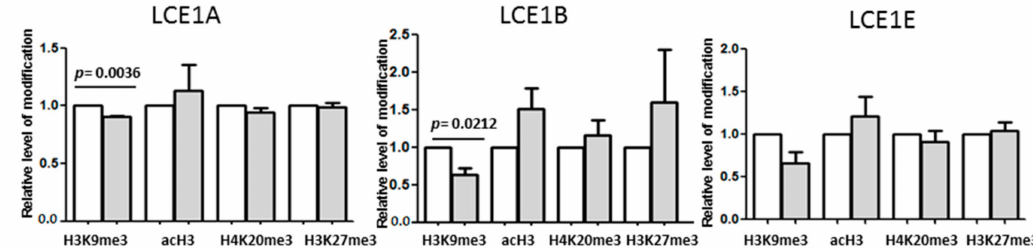
Figure 4. ChIP analysis of histone modifications present on promoters of selected LCE1 genes. The graphs represent relative level of histone H3 or H4 modifications (H3K9me3, H3ac, H3K27me3, H4K20me3) on promoters of LCE1A , LCE1B , and LCE1E genes in undi ff erentiated (white bars) and di ff erentiated (gray bars) HaCaT cells. The bars represent mean ± SEM calculated from n = 3–5 (depending on the modified histone) experiments. Statistically significant di ff erences are indicated by horizontal bars and the respective p